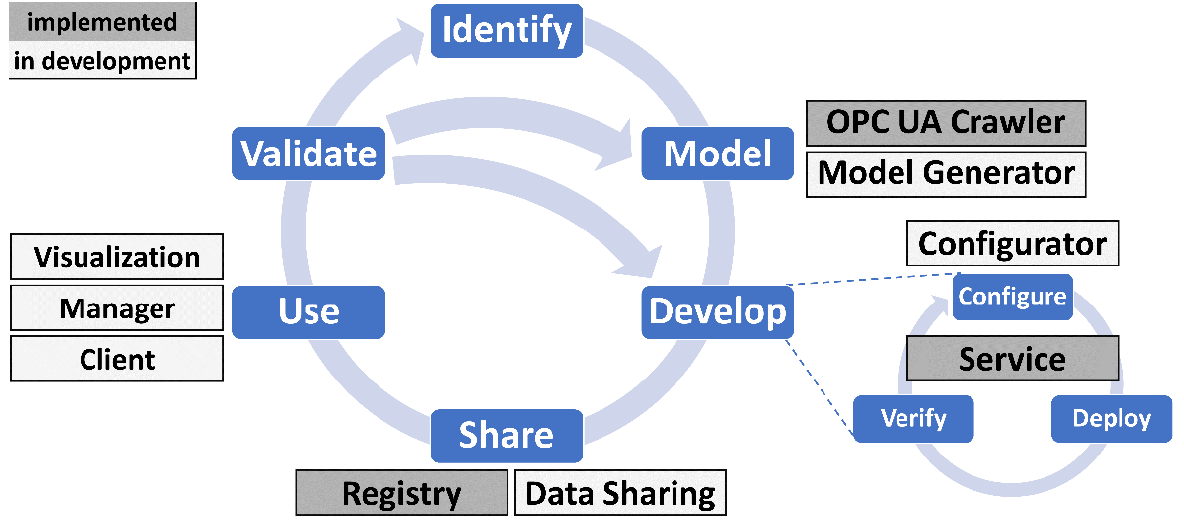
Figure 3. FA 3 ST tools for realizing the DT lifecycle.